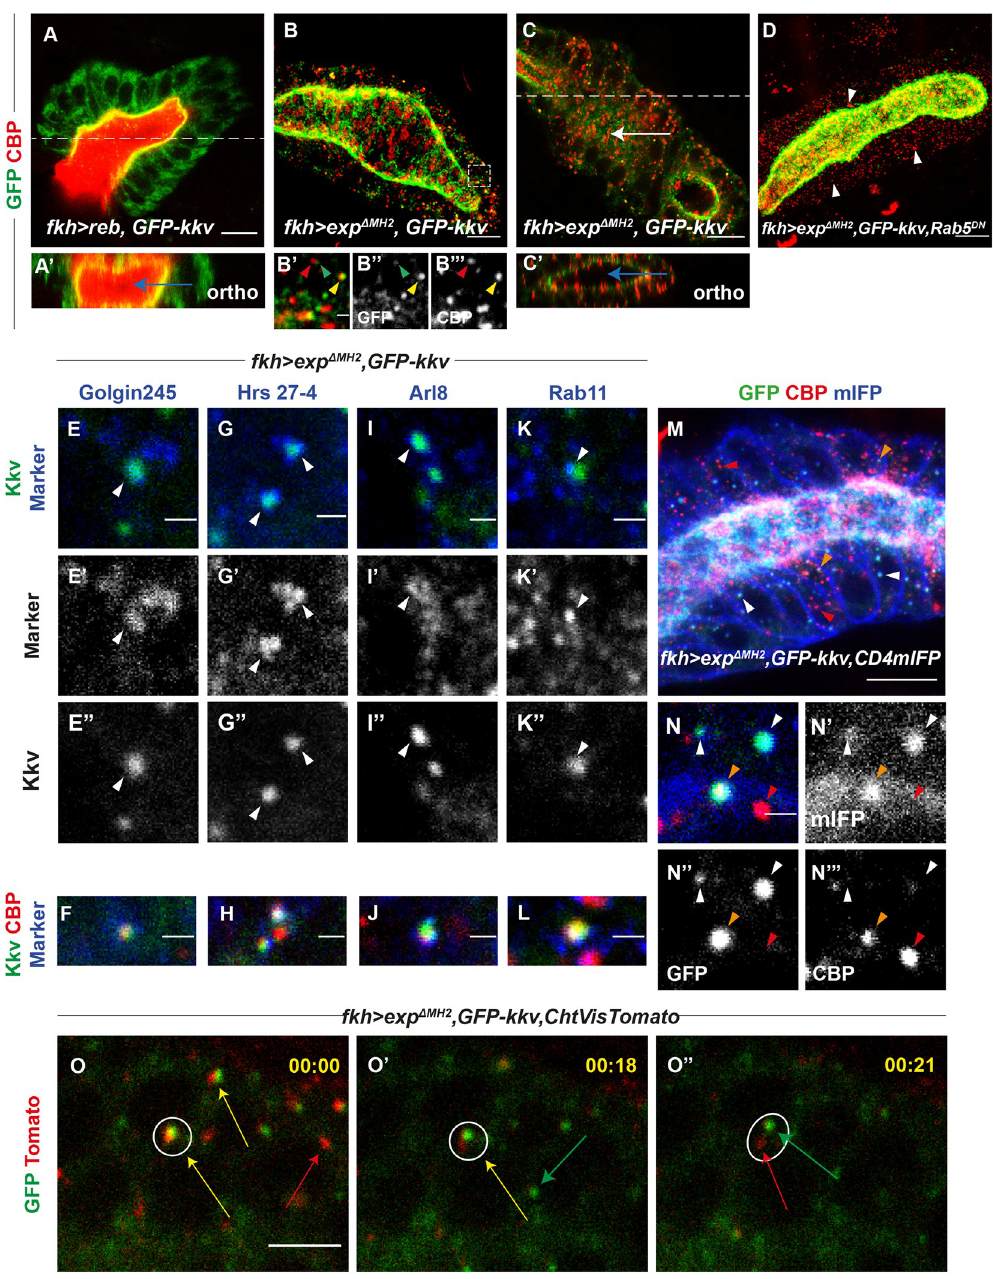
Fig 4. Analysis of intracellular chitin deposition. All images show salivary glands. ( A , C , E - L , N , O ) Show single confocal sections and ( B , D , M ) show projections of several sections. ( A - A’ ) The concomitant expression of reb and GFP-kkv leads to luminal chitin deposition (blue arrow in orthogonal section in A’ ). ( B , C ) Coexpression of exp Δ MH2 and GFP-kkv produces intracellular chitin punctae, some of which partially colocalise with GFP-Kkv vesicles (yellow arrowhead) while others do not (red arrowhead). GFP-Kkv vesicles without chitin are also observed (green arrowhead). Note the accumulation of chitin in the apical domain (white arrow in C ) that is not deposited extracellularly in the lumen (blue arrow in orthogonal section in C’ ). ( D ) In Rab5 DN background, intracellular chitin punctae are still present (white arrowheads). ( E - L ) Analysis of the nature of GFP-Kkv vesicles and chitin punctae using markers Golgin245 ( E - F ), Hrs 27–4 ( G - H ), Arl8 ( I - J ),and Rab11 ( K - L ); arrowheads indicate colocalisation between Kkv and each specific marker. ( M , N ) All GFP-Kkv vesicles colocalise with the membrane marker CD4-mIFP (white arrowheads), and few of them also with chitin (orange arrowheads); single chitin punctae do not colocalise with CD4-mIFP (red arrowheads). ( O - O” ) Frames from live imaging movie show that partially colocalising GFP-Kkv and chitin punctae (yellow arrow) can separate from each other; however, many GFP-Kkv (green arrow) and chitin puncta (red arrow) do not colocalise. Scale bars A - D , M : 10 μ m; E - L , N - N”‘ : 1 μ m; O - O” : 5 μ